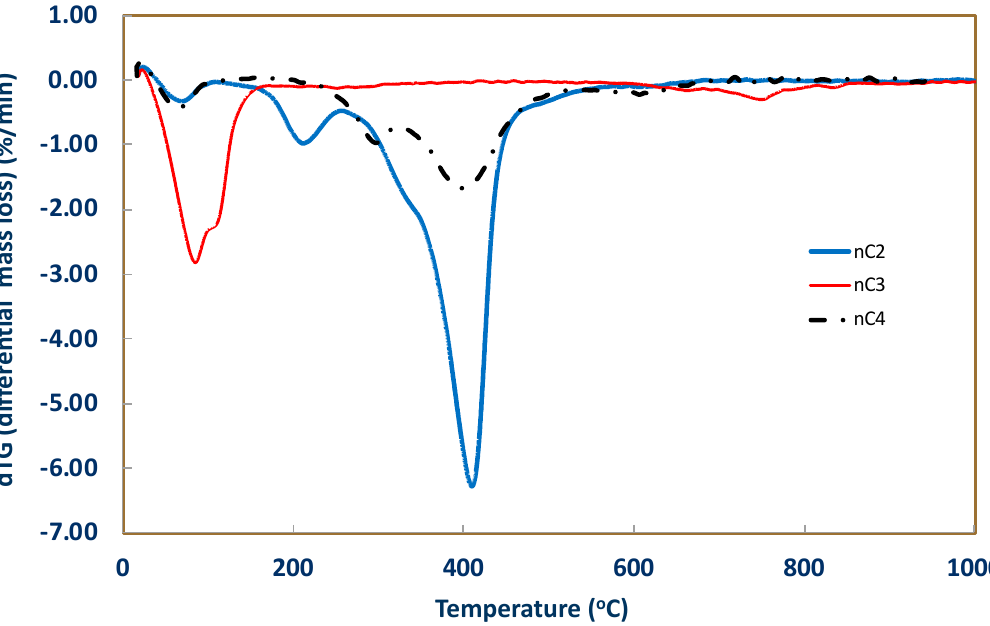
Figure 6. Comparison of Differential mass loss (dTG) of the organomodified montmorillonite (MMT) dispersion (nC2), inorganic MMT dispersion (nC3) [19], and organomodified MMT powder (nC4).